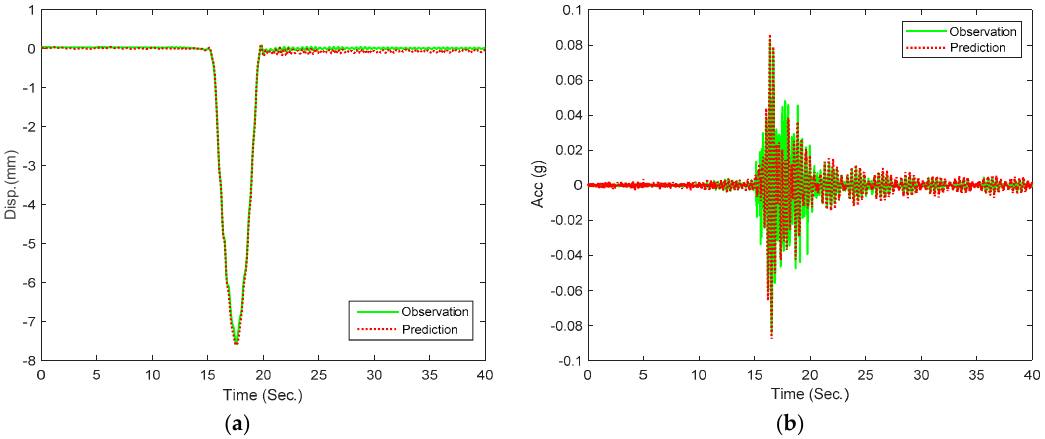
Figure 11. Prediction values in the time domain of the testing stage for a truck speed of 40 km/h; ( a ) semi-static and ( b ) acceleration.